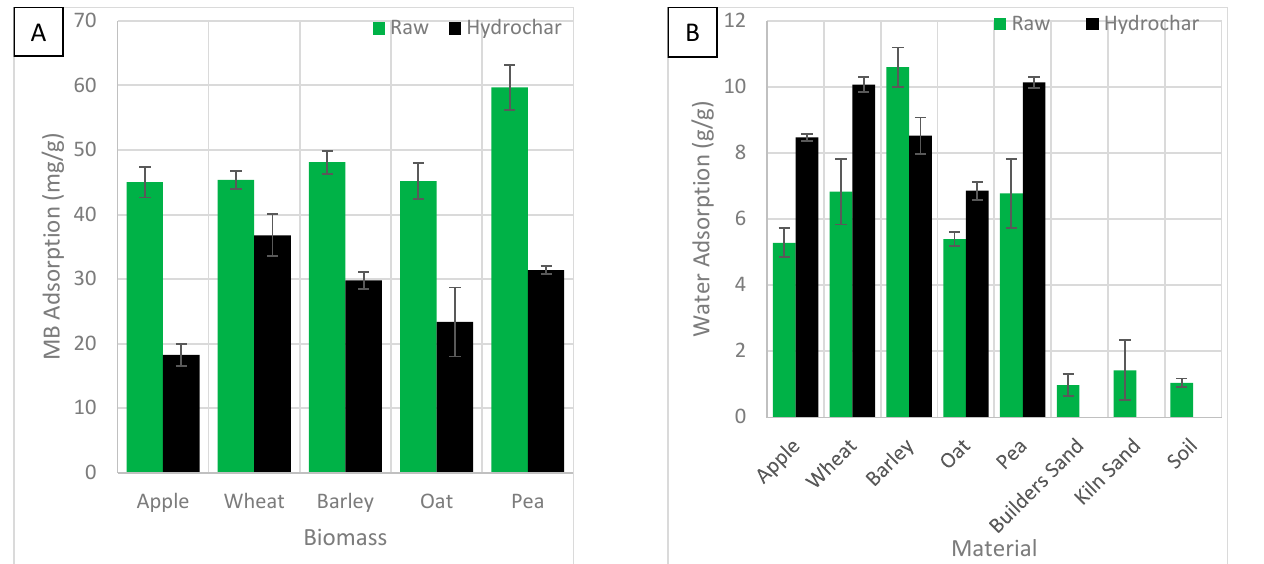
Figure 12. The effect of biomass feedstock on ( A ) MB adsorption and ( B ) water adsorption, including other mediums.